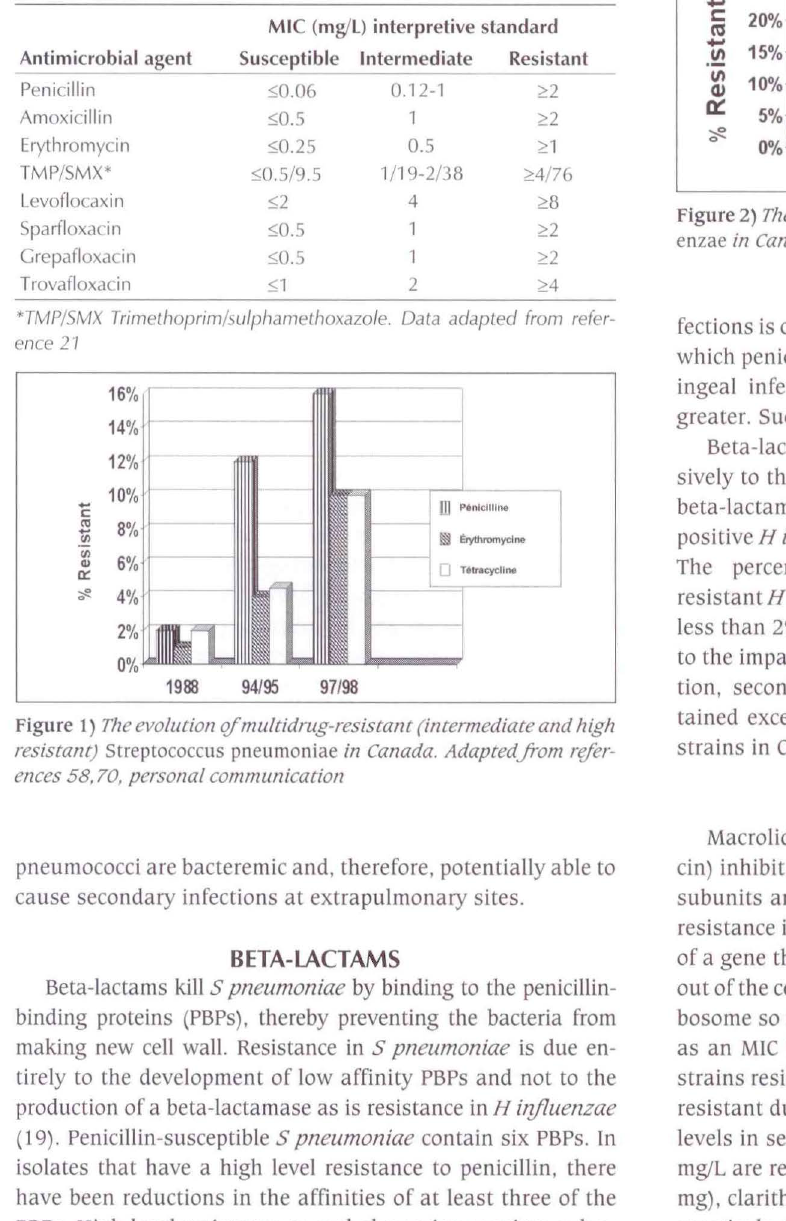
Minimal inhibitory concentration (MIC) interpretive standards for Streptococcus pneumoniae according to the January 1998 National Committee for Clinical Laboratory Standards' guidelines (Villanova, Pennsylvania)